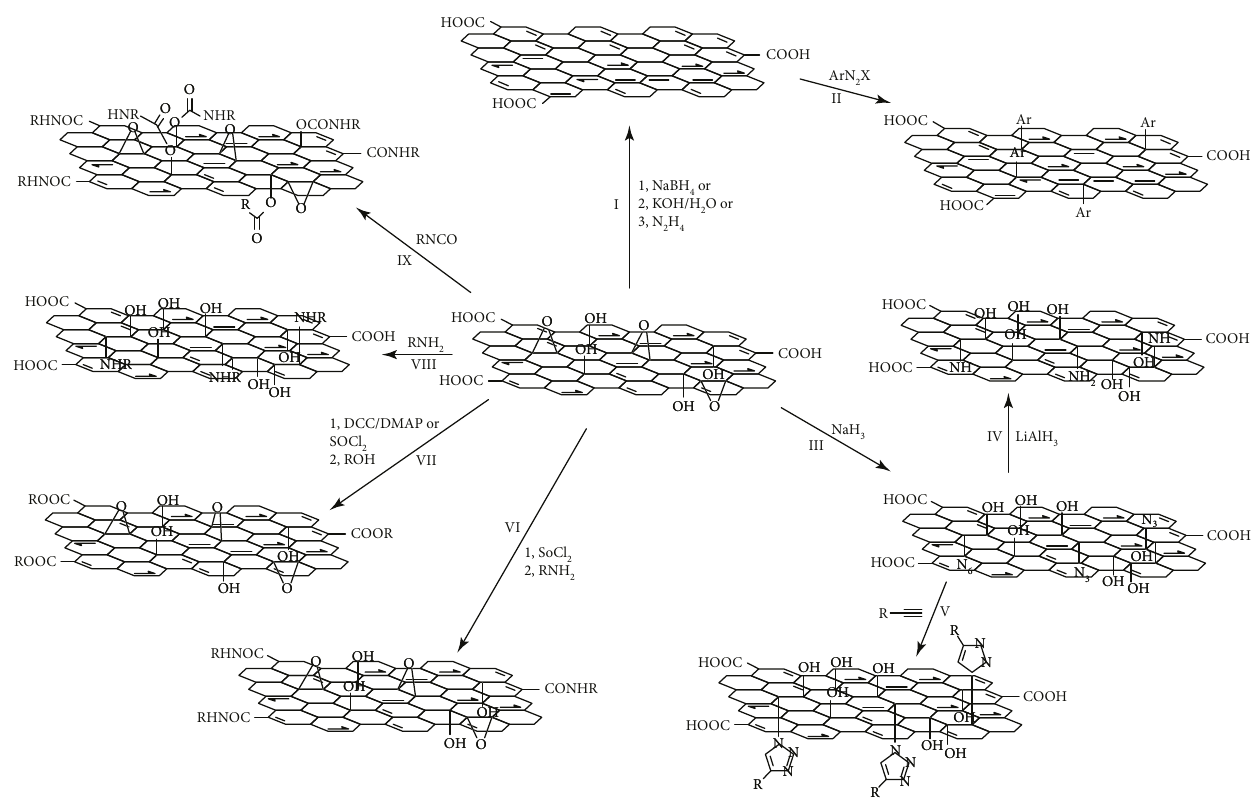
Figure 2: Schematic showing various covalent functionalization chemistries of graphene or GO. I: reduction of GO into graphene by , (2) KOH/H O, and (3) N H ). II: covalent surface functionalization of reduced graphene via various approaches ((1) NaBH 4 2 2 4 diazonium reaction (ArN2X). III: functionalization of GO by the reaction between GO and sodium azide. IV: reduction of azide functionalized GO (azide – GO) with LiAlH resulting in the amino-functionalized GO. V: functionalization of azide – GO through click 4 chemistry (R – ChCH/CuSO ). VI: modi fi cation of GO with long alkyl chains ((1) SOCl and (2) RNH ) by the acylation reaction 4 2 2 between the carboxyl acid groups of GO and alkylamine (after SOCl activation of the COOH groups). VII: esteri fi cation of GO by 2 activation of the DCC chemistry or the acylation reaction between the carboxyl acid groups of GO and ROH alkylamine (after SOCl 2 COOH groups) ((1) DCC/DMAP or SOCl and (2) ROH). VIII: nucleophilic ring-opening reaction between the epoxy groups of GO and 2 the amine groups of an amine-terminated organic molecular (RNH ). IX: the treatment of GO with organic isocyanates leading to the 2 derivatization of both the edge carboxyl and surface hydroxyl functional groups via formation of amides or carbamate esters (RNCO)